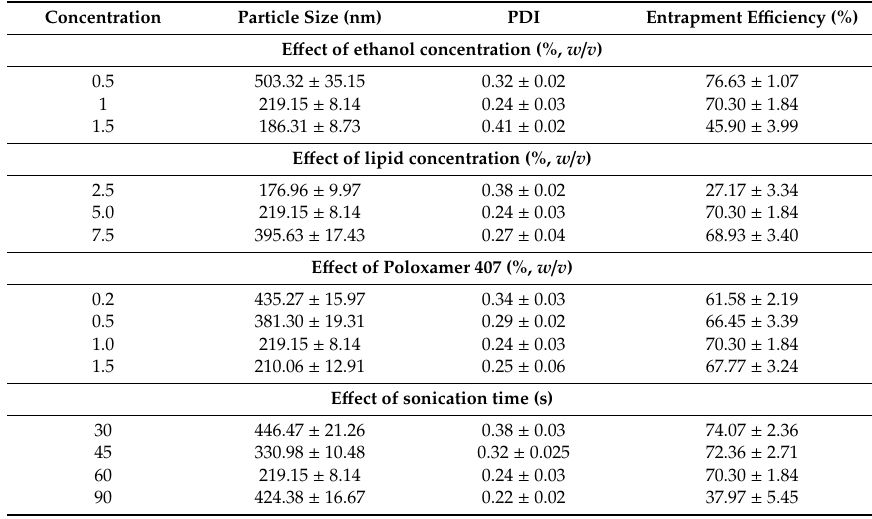
Table 1. E ff ect of ethanol concentration, lipid concentration, Poloxamer 407 concentration and sonication time on particle size, polydispersity index (PDI) and entrapment e ffi ciency of rosuvastatin liquid crystalline nanoparticles